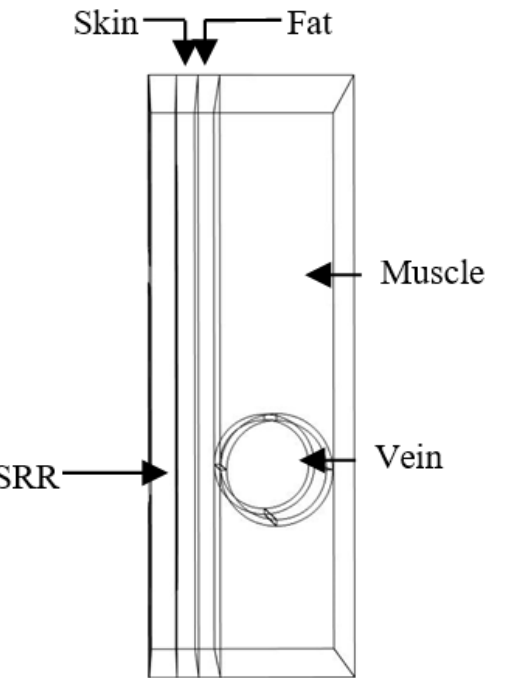
Figure 4. Simulated model of the forearm of an overweight person in contact with the